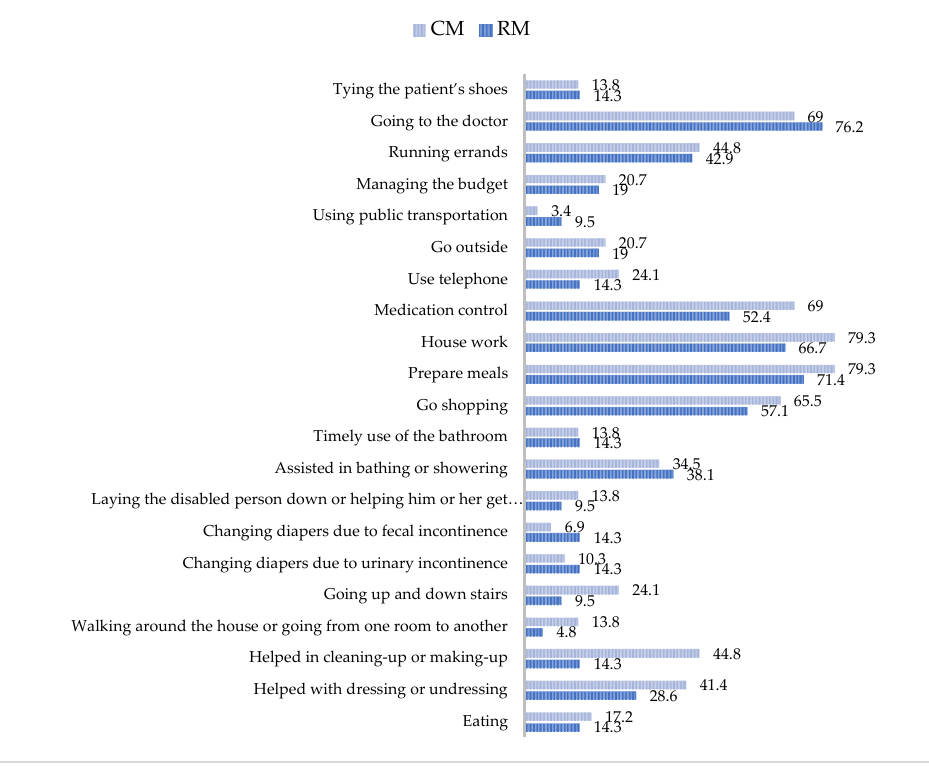
Figure 2. Percentages of activities performed by the informal caregivers. RM = remote monitoring; CM = conventional monitoring. Healthcare 2020 , 8 , x